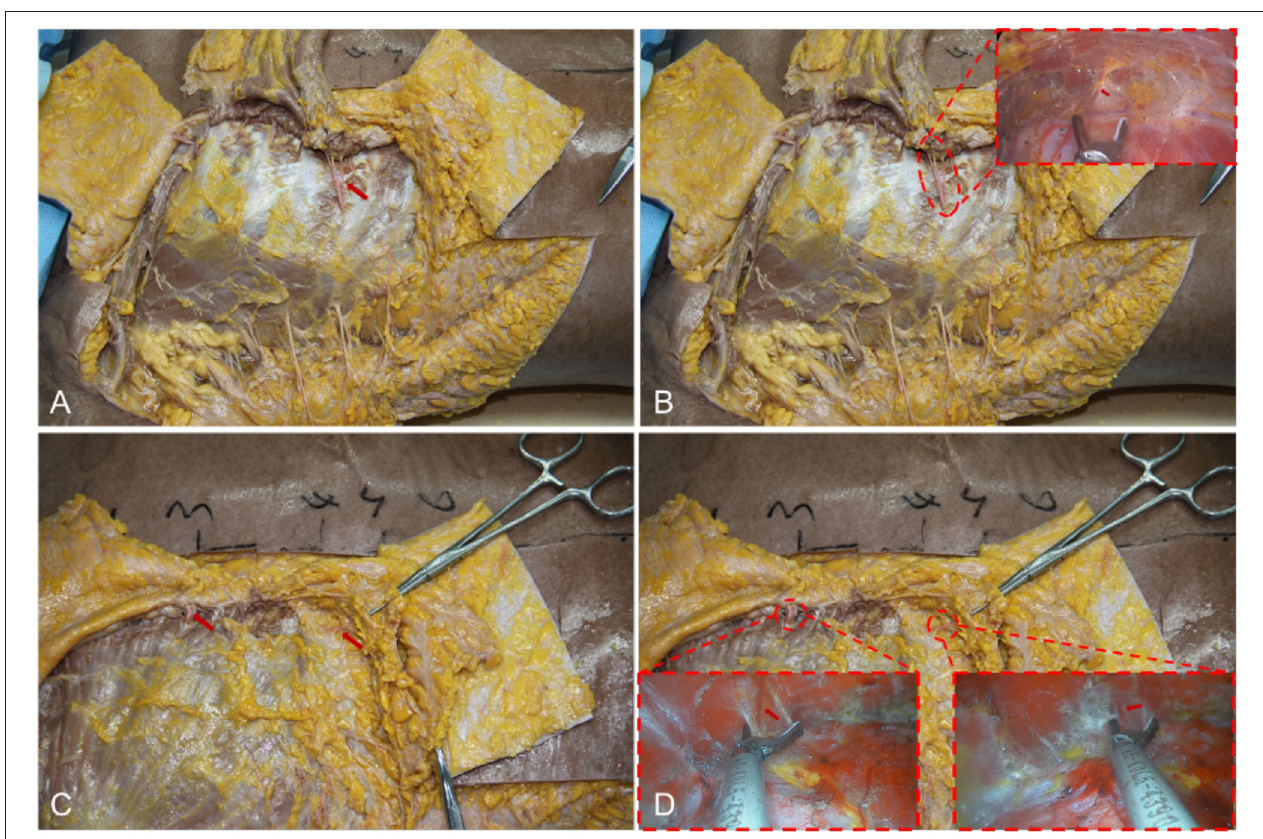
FIGURE 8 | The vessels’ anatomy of the lower and lateral pocket. (A) Arrow indicates a vascular bundle from intercostal to pectoralis major muscle in the fourth intercostal space. (B) Vascular anatomy of lower pocket combined with an endoscope. (C) Arrows indicate a group of vascular and nerve bundles in the 2–3 intercostal and 4–5 intercostal spaces on the lateral edge of the sternum. (D) Vascular anatomy of lateral pocket combined with an endoscope.